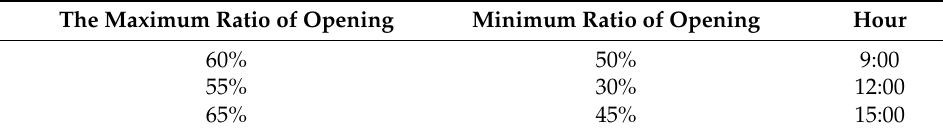
Table 8. Best values for the opening ratio of shading device on December 21st. The Maximum Ratio of